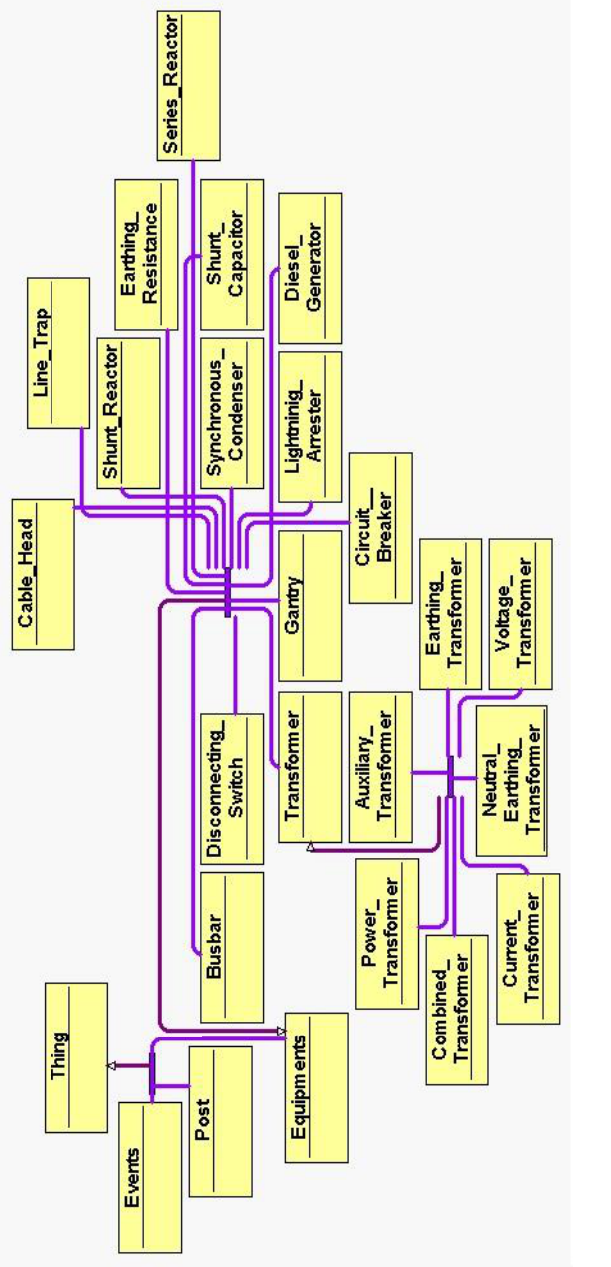
Figure 3. Ontology used for Database 1